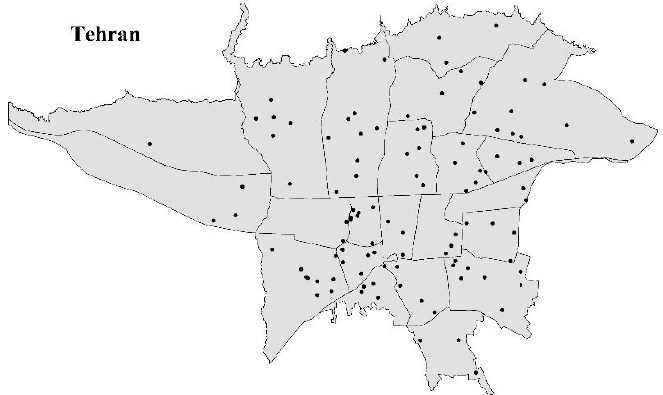
Figure 1. Location map of the study area showing the sampling sites.